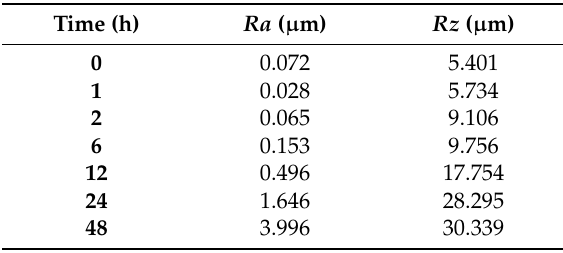
Table 1. Averages of surface roughness for Ra , Rz